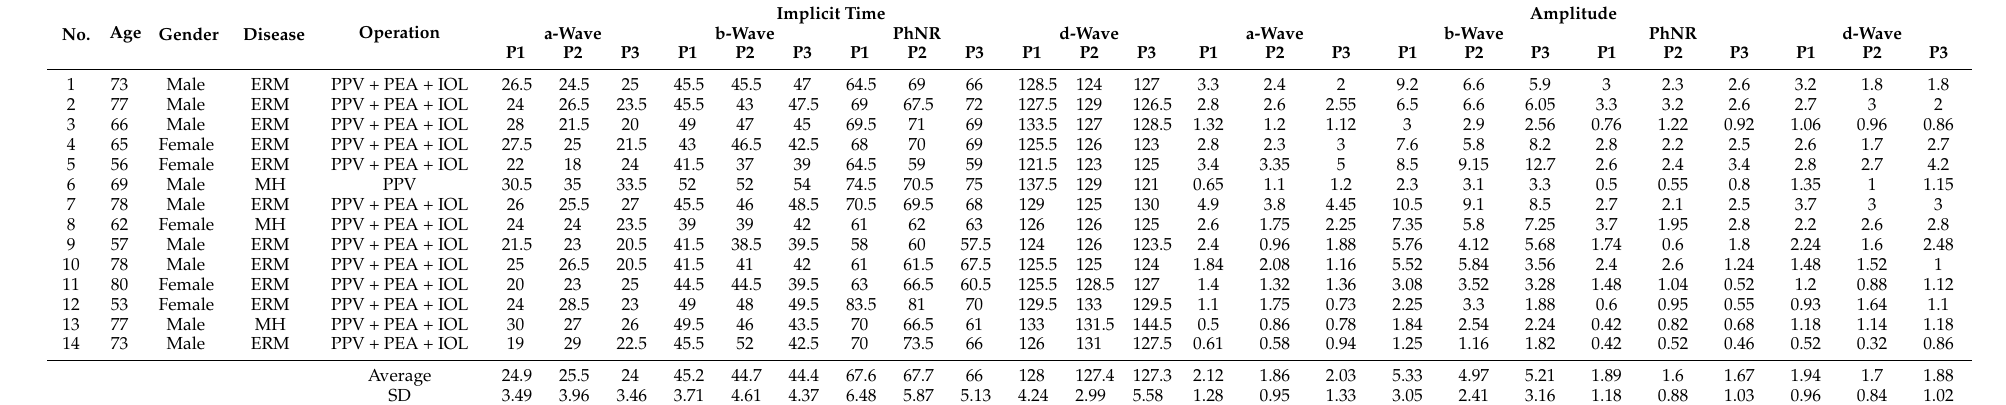
Table 1. The demographic of the patients and the measured values of each component of the